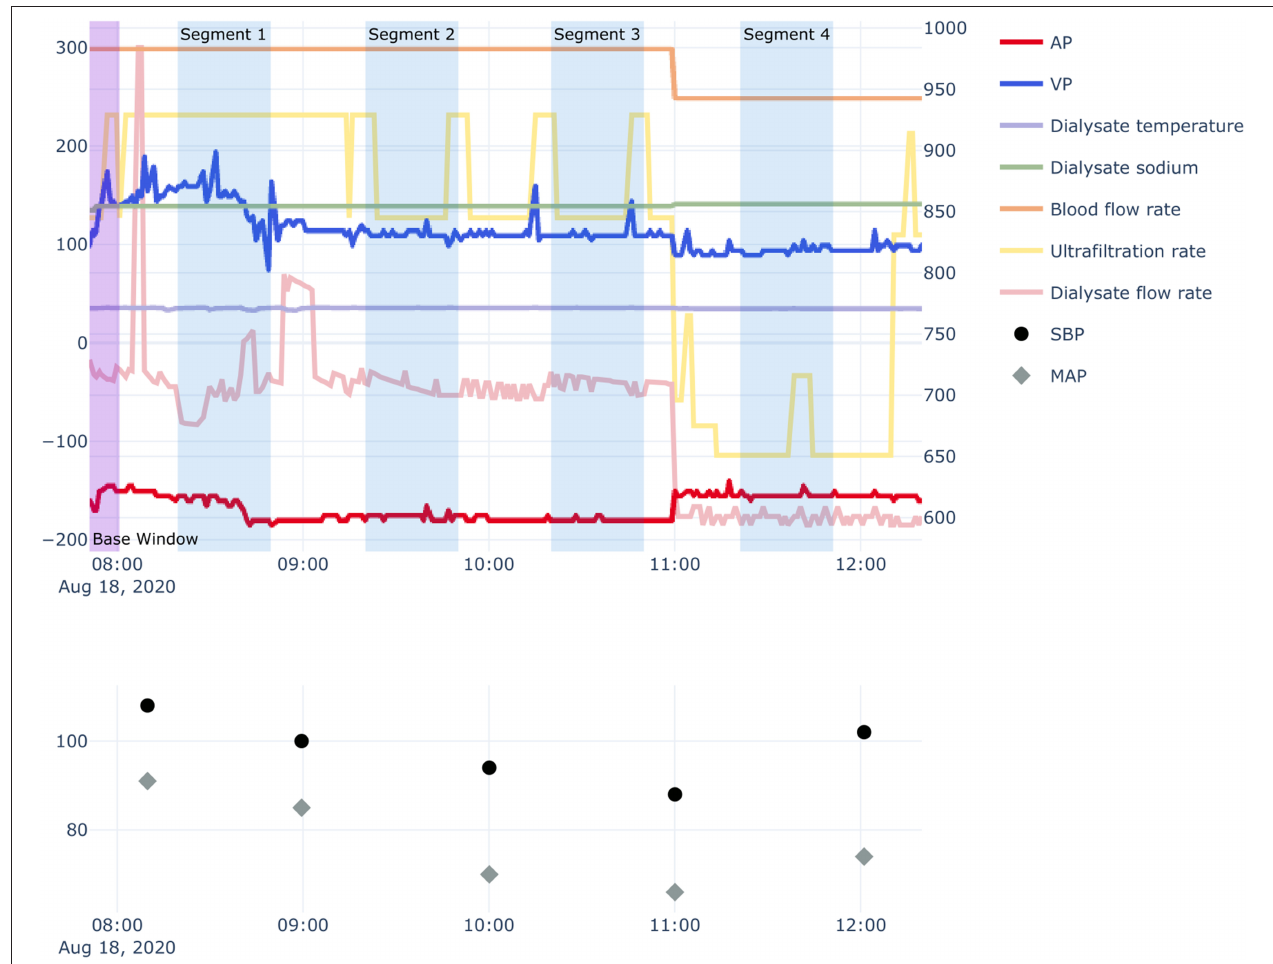
FIGURE 2 | Example of hemodialysis session and segmentation recognition. AP, arterial pressure; VP, venous pressure; SBP, systolic blood pressure; MAP, mean arterial pressure. Segments contain hemodialysis-related measurement data obtained for 30min, 10min before each time-point of SBP measurement. Bottom panel: 10min of data from the start of hemodialysis were used to adjust the volatility of the AP and VP for each